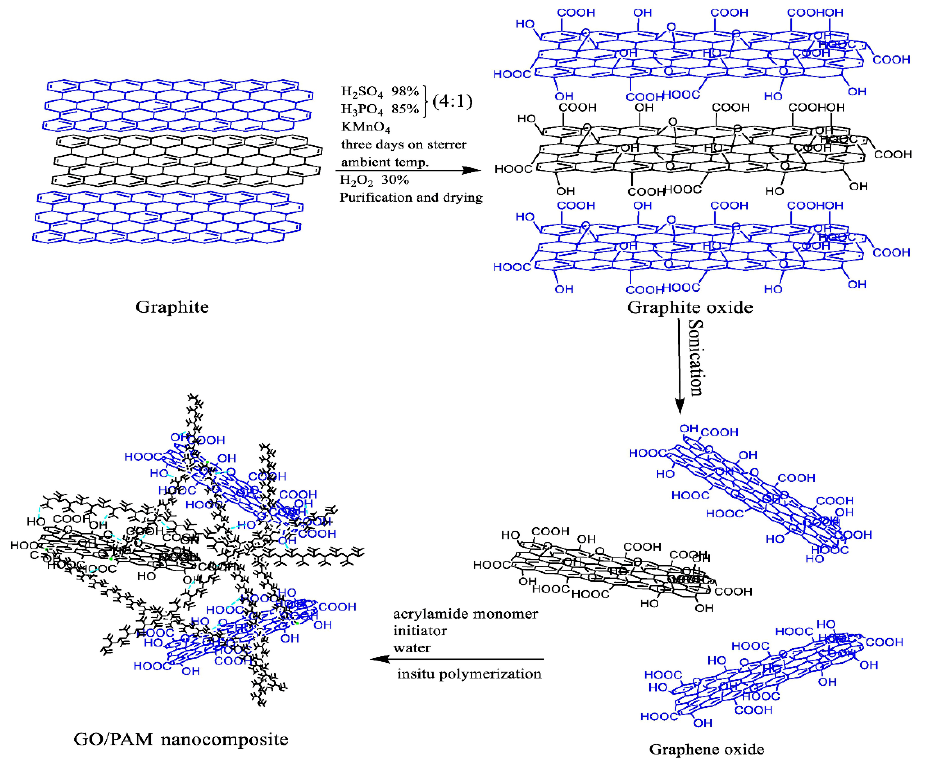
Figure 10. Structural representation of GO/PAM nanocomposite fabrication. Reproduced with permission from [116]. Copyright Elsevier, 2020.